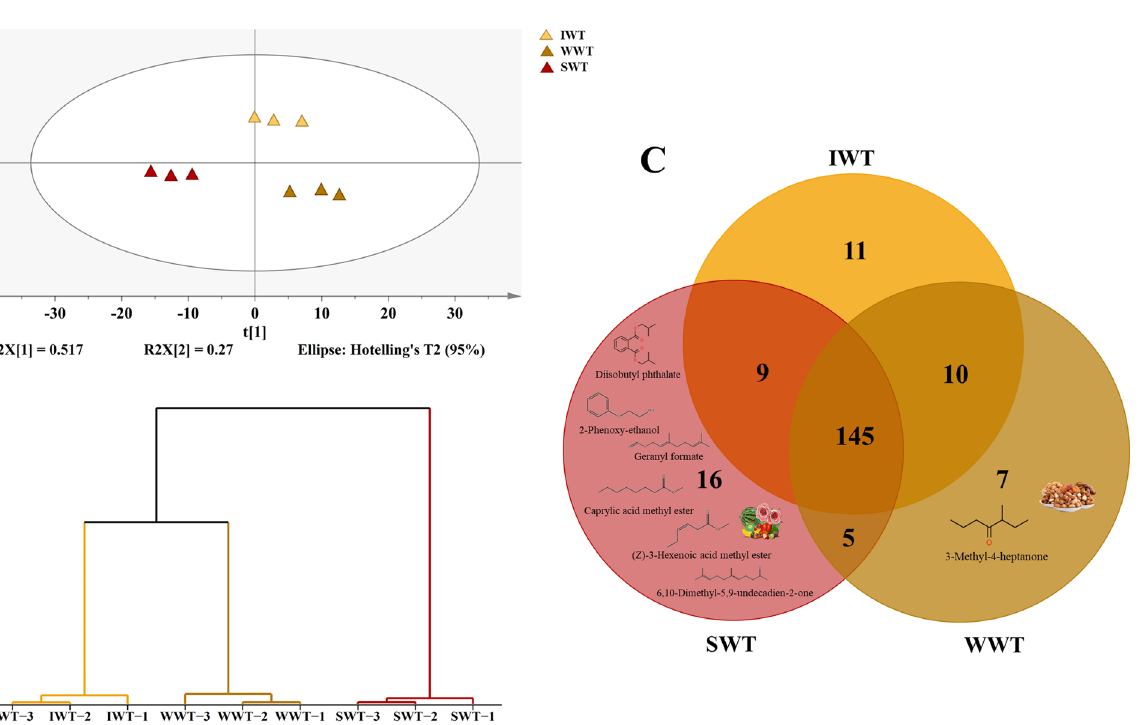
Figure 3. Overall differences in volatile compounds among white teas. ( A ) Principal component analysis, ( B ) hierarchical cluster analysis, ( C ) Venn diagram; diisobutyl phthalate, geranyl formate, caprylic acid methyl ester, (Z)-3-hexenoic acid methyl ester, 2-phenoxy-ethanol, 6,10-dimethyl-5,9- undecadien-2-one are volatile compounds with floral or fruity odor and are only present in SWT. 3-Methyl-4-heptanone are volatile compounds with nutty odor and are only present in WWT (SWT: sunlight withering-treated white tea; WWT: withering-tank withering-treated white tea; IWT: indoor withering-treated white tea).